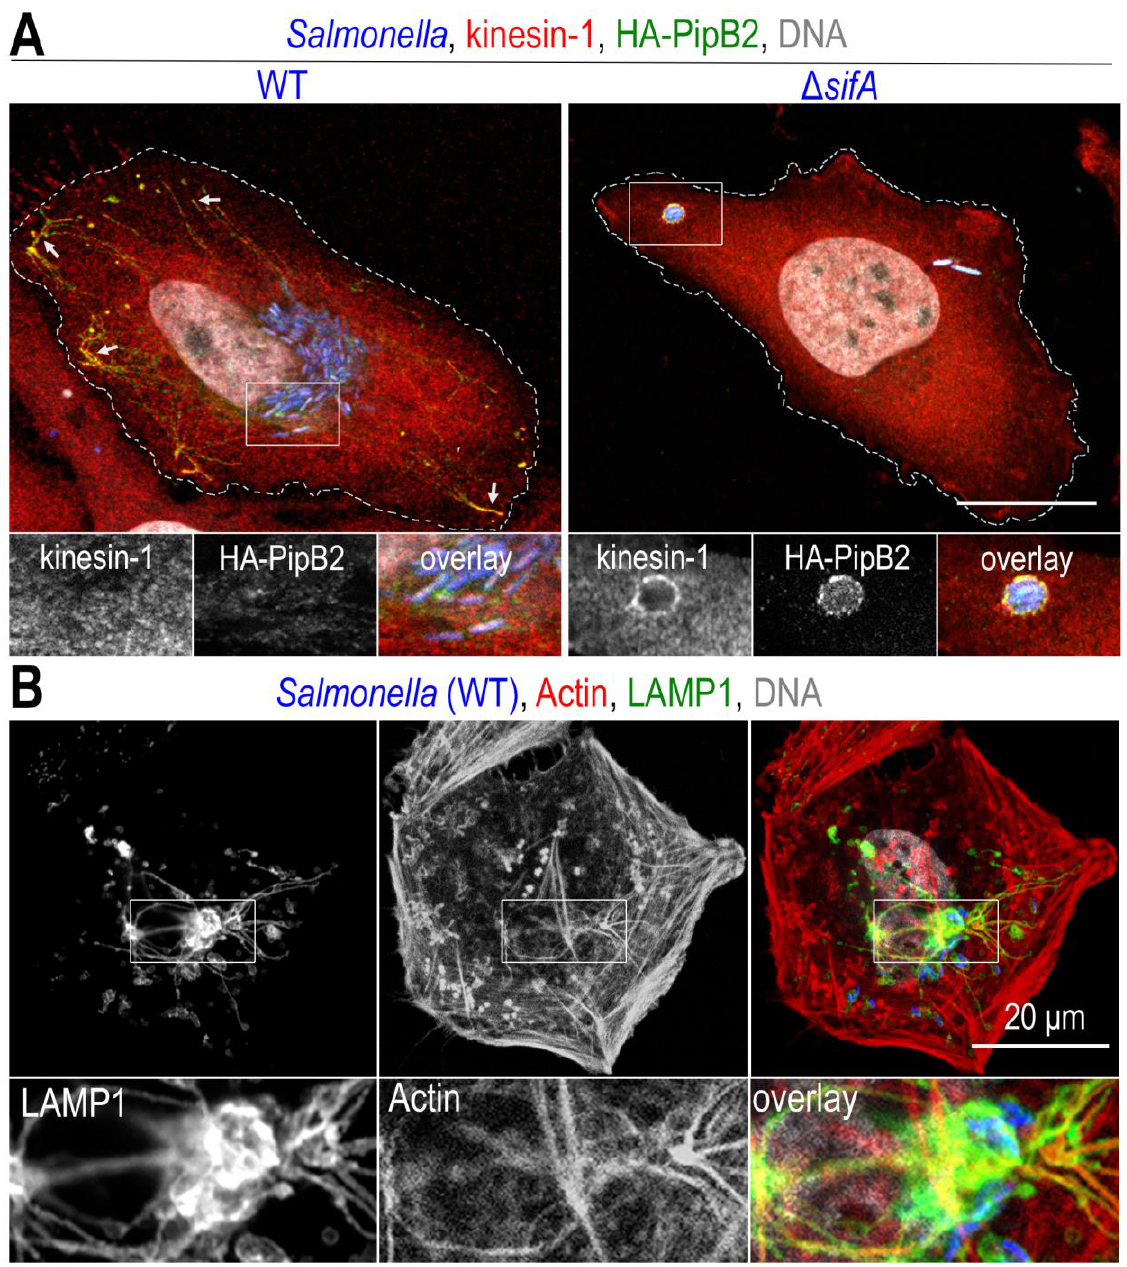
FIGURE 4: Recruitment of molecular motors and the actin cytoskeleton on Salmonella vacuoles. Confocal microscopy images, after immu- nolabelling, of Salmonella -infected HeLa ( A ) or Cos-7 ( B ) cells at a late time (12h) of infection. ( A ) Two effectors of T3SS-2, SifA and PipB2 recruit kinesin-1 to SCVs and SITs. The presence of kinesin-1 (red) and PipB2 (green) is detected at the tip of SITs (arrows) in cells infected with wild-type (WT) Salmonella ( blue), while these molecules are difficult to detect on SCVs (see inset). In the absence of SifA (∆ sifA ), kine- sin-1 and membrane effectors accumulate on SCVs. ( B ) Actin labelling (red) highlights the presence of a strong actin cortex. Actin is also present around the juxtanuclear Salmonella microcolony (blue) and also marks the SIT network (LAMP1, in green). Scale bars, 20 or 10 μm for the magnified insets in ( A ) and 6.7 μm for the magnified insets in ( B ). This figure is composed of unpublished OPEN ACCESS | www.microbialcell.com